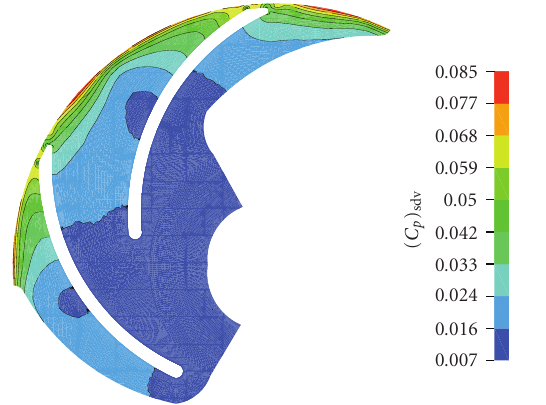
Figure 8: Time-averaged relative vector in the impeller, midspan, 0.5 Q des .